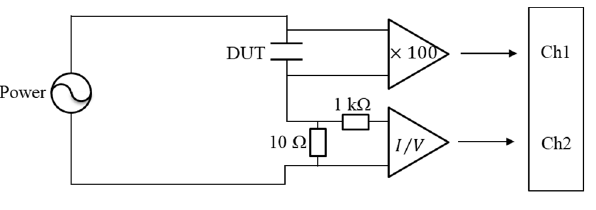
Figure 2. Measuring circuit for the EDLCs.